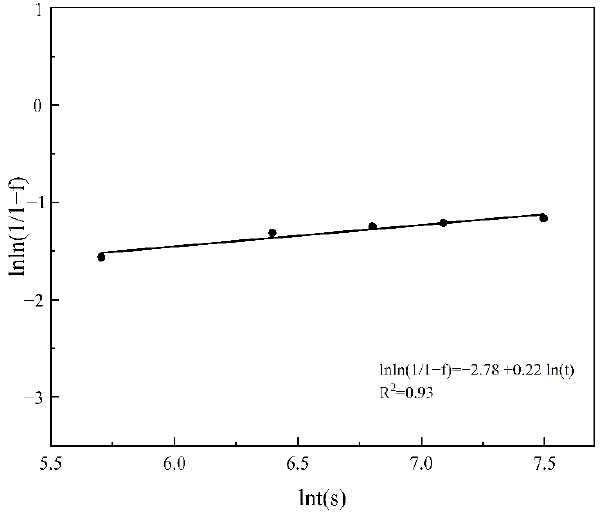
Figure 10. Plot of ln{ln = [1/(1 − f )]} versus ln( t